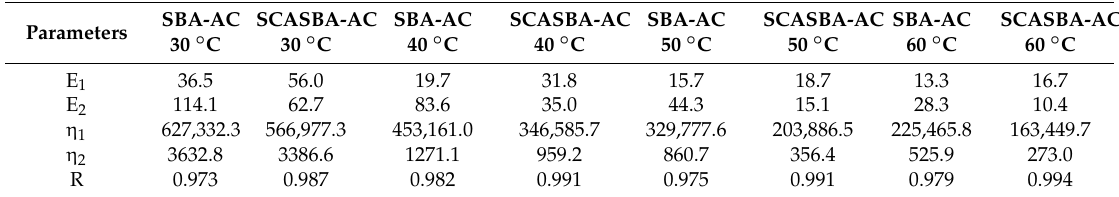
Table 8. Static creep Burger’s model parameters of asphalt mixture under different temperatures.